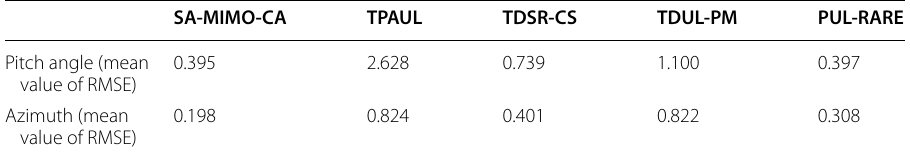
Table 2 The relationship between the SNR of the elevation angle and the azimuth angle and the mean square